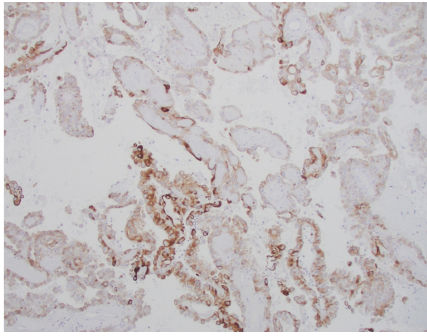
Figure 8: Diffuse membranous positivity to HMWK 903 immunos- tain.